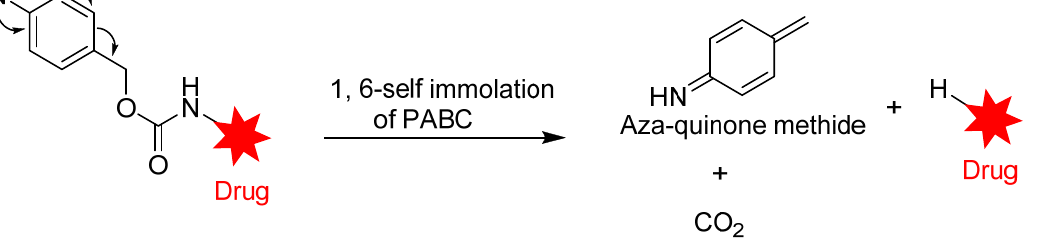
Figure 8. Straightforward cleavage mechanism of p-aminobenzyl carbamate (PABC) containing conjugate.